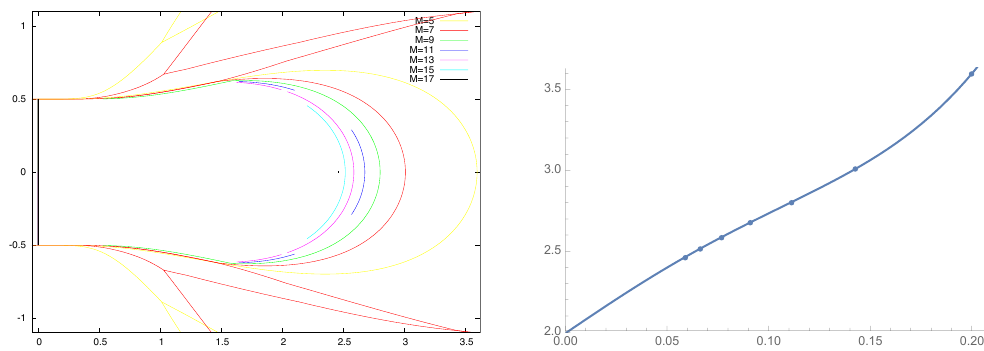
Figure 6 . Left panel: partial results for the inner parts of the curves of accumulation points for odd M = 5 ; 7 ; (cid:1) (cid:1) (cid:1) ; 17. Right panel: extrapolation of the (cid:12)rst real intersection, using a polynomial (cid:12)t in the variable 1 =M